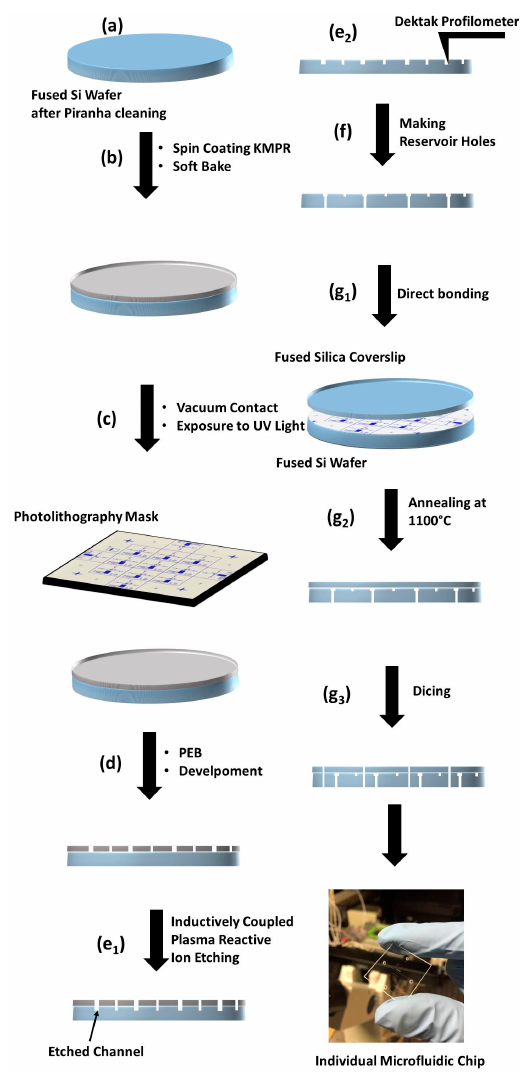
Figure 1. Schematic diagram of the procedure employed in the fabrication of T-mixer microfluidic chips. (d)